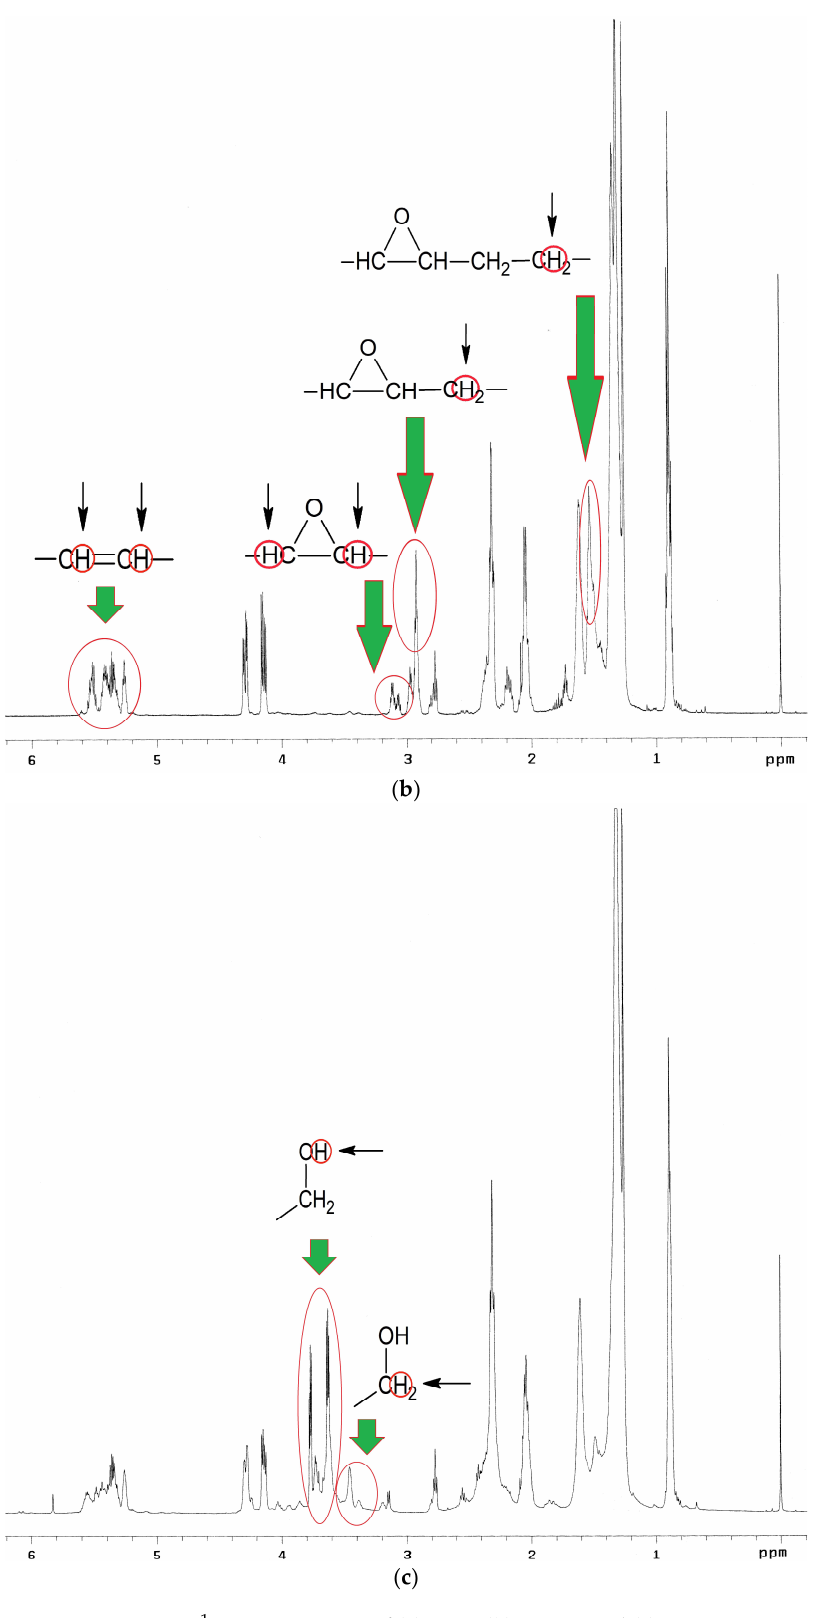
Figure 5. 1 H NMR spectra of ( a ) EPO, ( b ) EPEO, and ( c ) EPB.